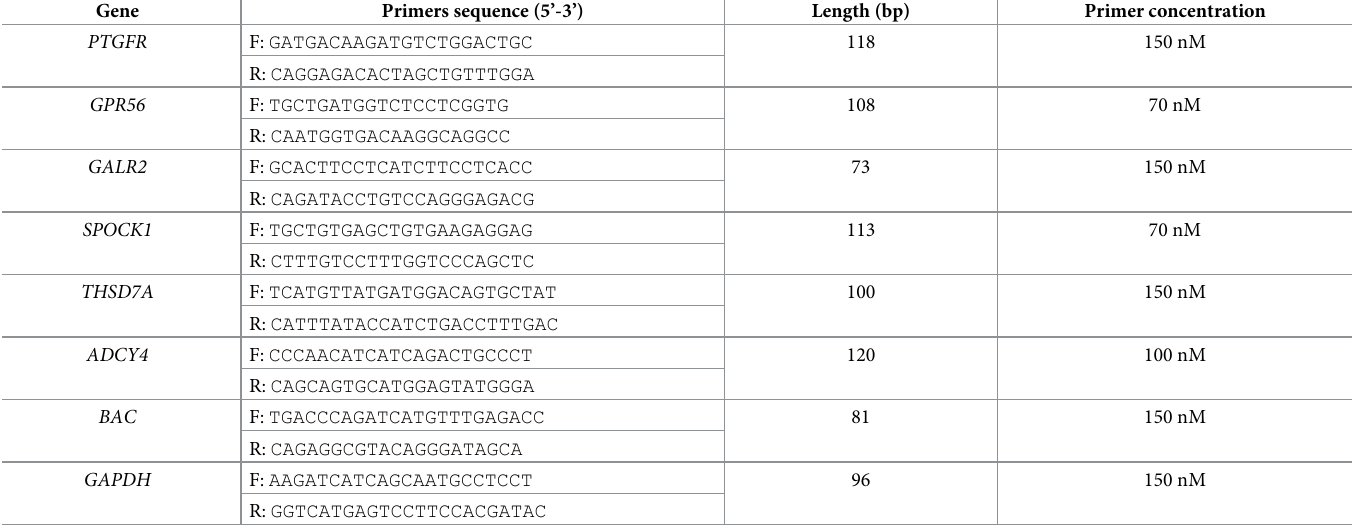
Table 2. Primer sequences used for real time PCR